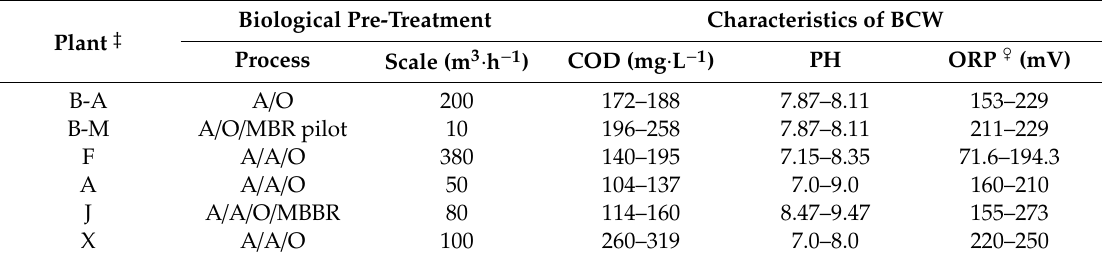
Table 1. Characteristics of bio-treated coking wastewater (BCW) and bio-treatment processes in di ff erent coking plants. Plant